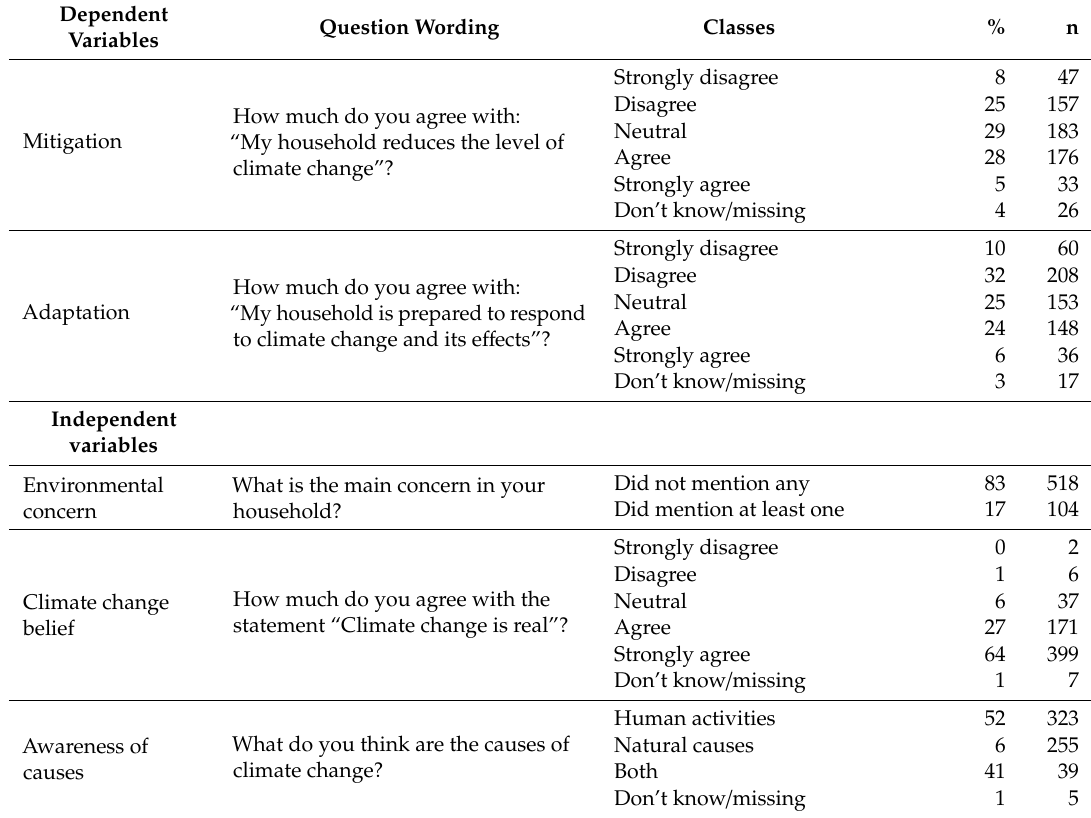
Table 1. Summary of household views on climate change (n = 622).